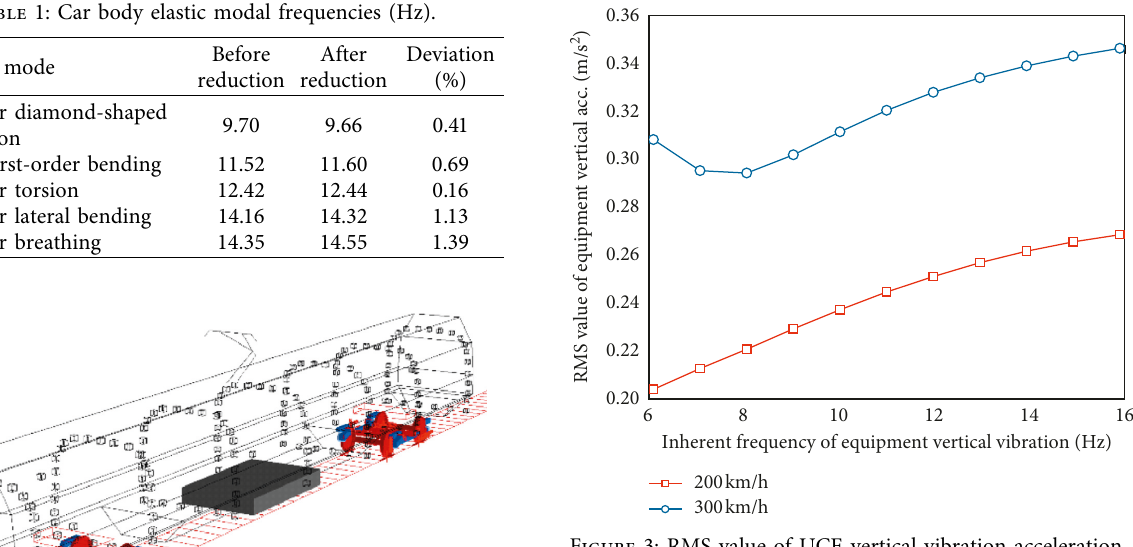
Figure 3: RMS value of UCE vertical vibration